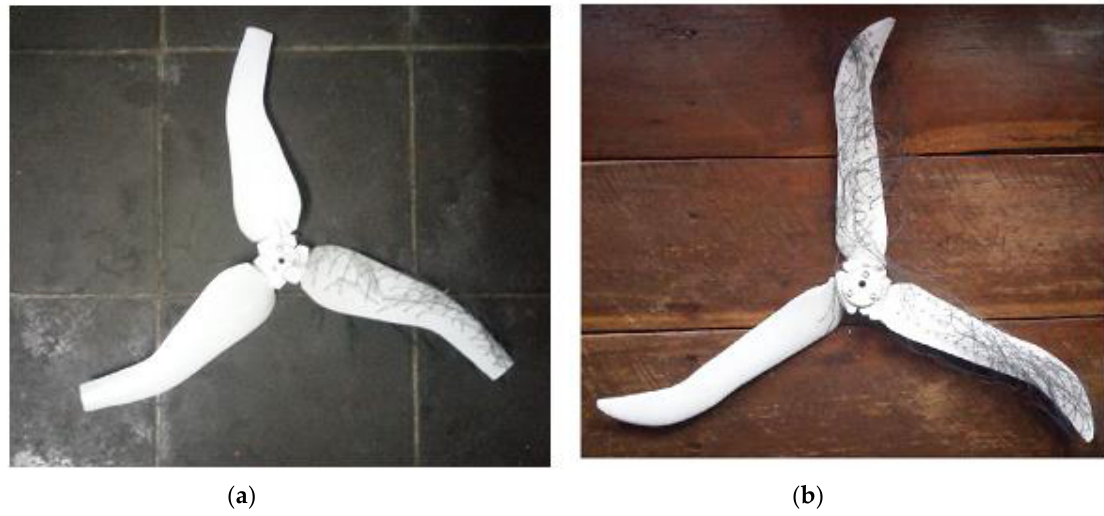
Figure 2. Calculated performance of the design was approximated by the blade element method (BEM).